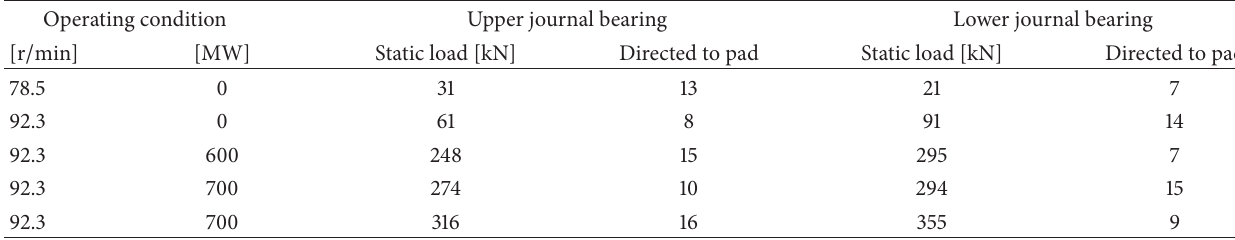
Table 4: Static loads in a LHG journal